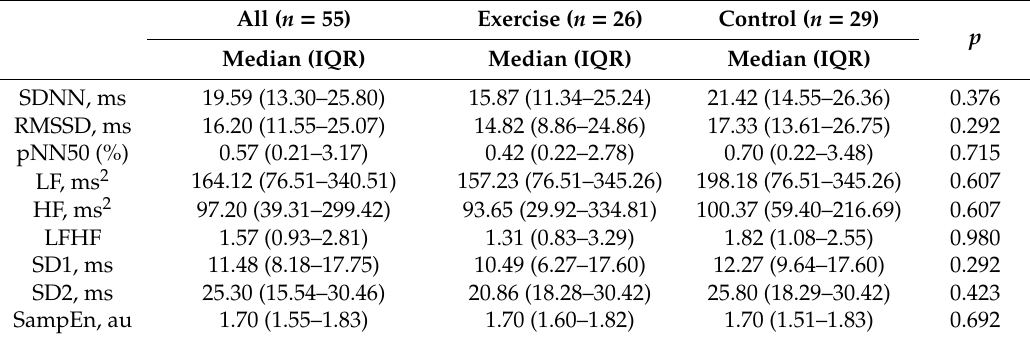
Table 2. Baseline heart rate variability (HRV) derived parameters of the study